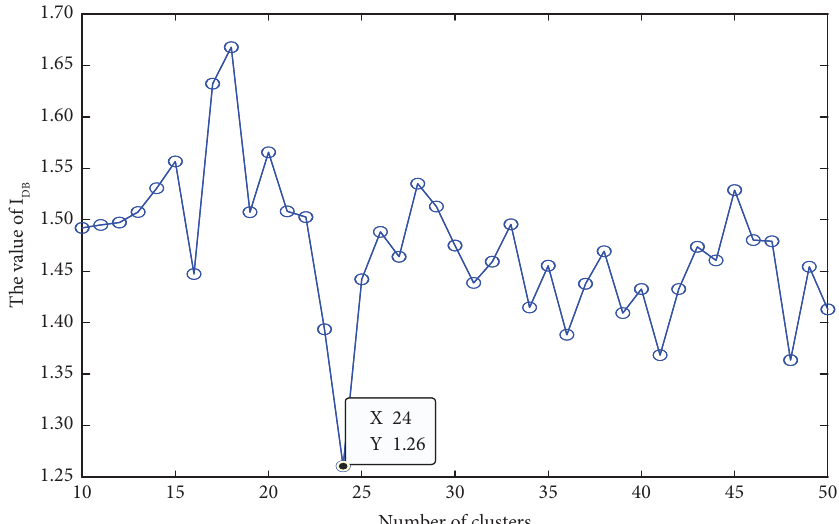
Figure 5: Davis Bolding index